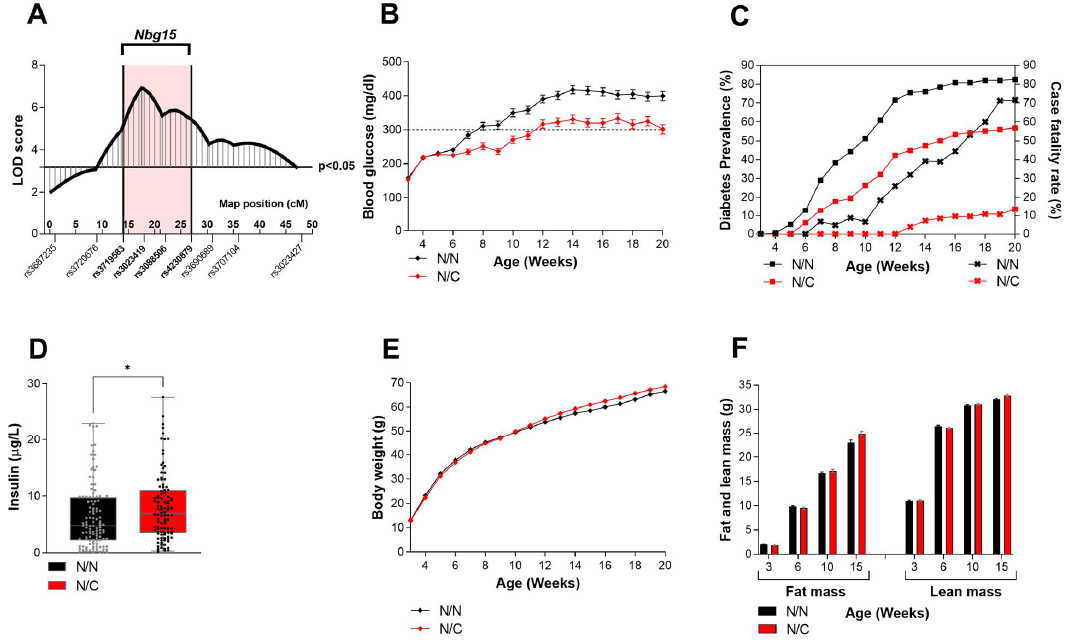
Figure 1. Nbg15 heterozygous carriers of the C3H alleles demonstrate improved blood glucose levels independently of their body weight. Blood glucose QTL on chromosome 15 identified in the backcross (C3HxNZO)N2 population with the defined Nbg15 locus (genotyping markers rs37195830 to rs4230879, 50–80 Mbp) ( A ). Allele specific segregation of blood glucose development ( B ), diabetes prevalence (squares) and case fatality rate (x) ( C ), plasma insulin levels ( D ), body weight ( E ), body composition ( F ). LOD scores were calculated using R/qtl package. Allelic segregation was performed using the genotyping markers indicated in bold in the x axis ( A ), n = 118–172. Data are presented as box and whiskers (min to max) ( D ) and mean ± SEM ( B , E , F ) and were analyzed by Students t test, * p < 0.05 ( D ); or estimated by 100 permutation test in the QTL analysis ( B , E , F ). Diabetic mice ( C ) were determined as animals with random blood glucose equal or over 300 mg/dl exceeded for at least three weeks in a row. Case fatality rate ( C ) was calculated based on the number diabetic mice that died during the experimental period (20 weeks). 2.2. Introgression of the Nbg15/C3H Locus into the NZO Genome Protects Mice from Chronic Hyperglycemia To investigate the genetic causality as well as to validate the pathophysiological mechanisms associating the Nbg15 locus to pancreatic islets integrity, recombinant congenic strains (RCS) were generated carrying either the full Nbg15 /68.7 C/C (consomic, Con. Nbg15 C3H/C3H ), proximal Nbg15 /65 C/C (Prox. Nbg15 C3H/C3H ) or distal Nbg15 /30.3 C/C (Dis. Nbg15 C3H/C3H ) Nbg15 locus from C3H and compared to the control Nbg15 /95.5 N/N group ( Nbg15 NZO/NZO ) (Figure 2A). Phenotypic characterization of these mice under high- fat diet-feeding (45 cal% from fat) demonstrated a general protection of Nbg15 /C3H mice from developing hyperglycemia (Figure 2B, Supplemental Table S1). Starting at 9 weeks of age, Con. Nbg15 C3H/C3H animals displayed significantly lower blood glucose levels in comparison to Nbg15 NZO/NZO controls. Moreover, blood glucose levels of Prox. Nbg15 C3H/C3H mice were lower only at weeks 11 and 12. In the Dis. Nbg15 C3H/C3H group, lower blood glucose levels appeared at later stages of age, reaching statistical significance at weeks 12, 14 and 15 (Figure 2B, Supplemental Table S1). In addition, whereas 55% of Nbg15 NZO/NZO mice presented blood glucose levels of >500 mg/dl, only 30% of Prox. Nbg15 C3H/C3H mice displayed severe hyperglycemia. Moreover, only 6% and 5% of the Dis. Nbg15 C3H/C3H and Con. Nbg15 C3H/C3H animals, respectively, developed blood glucose levels above this blood